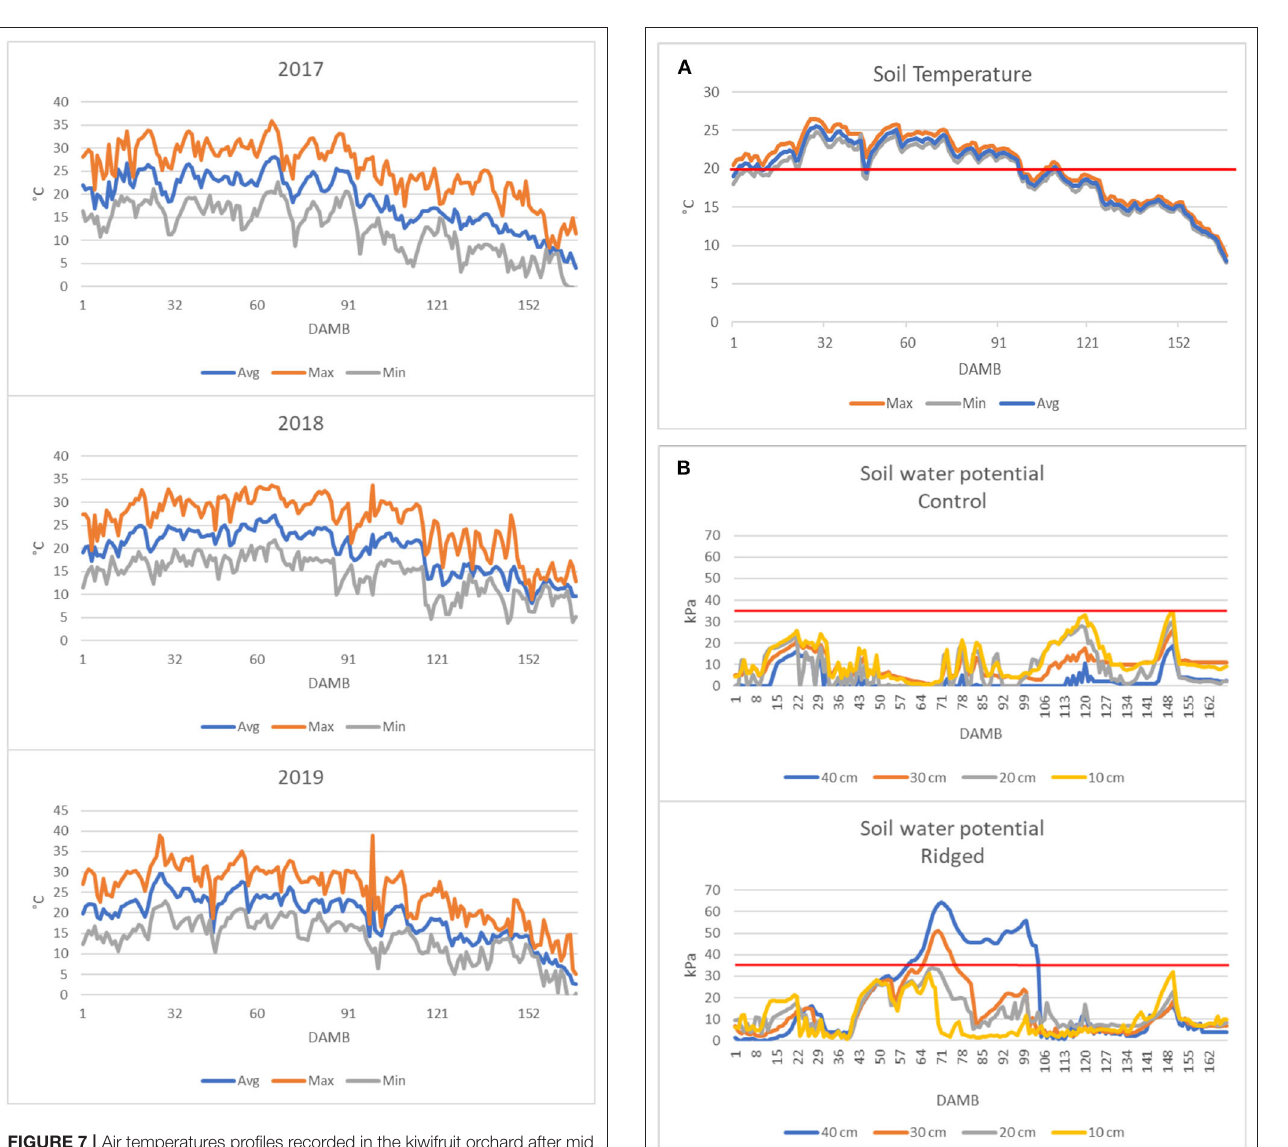
FIGURE 7 | Air temperatures profiles recorded in the kiwifruit orchard after mid bloom during the growth seasons concerned by the trial (Min, minimum; Max, maximum; Avg, average). FIGURE 8 | Soil temperature monitored at 20cm depth (A) and soil water